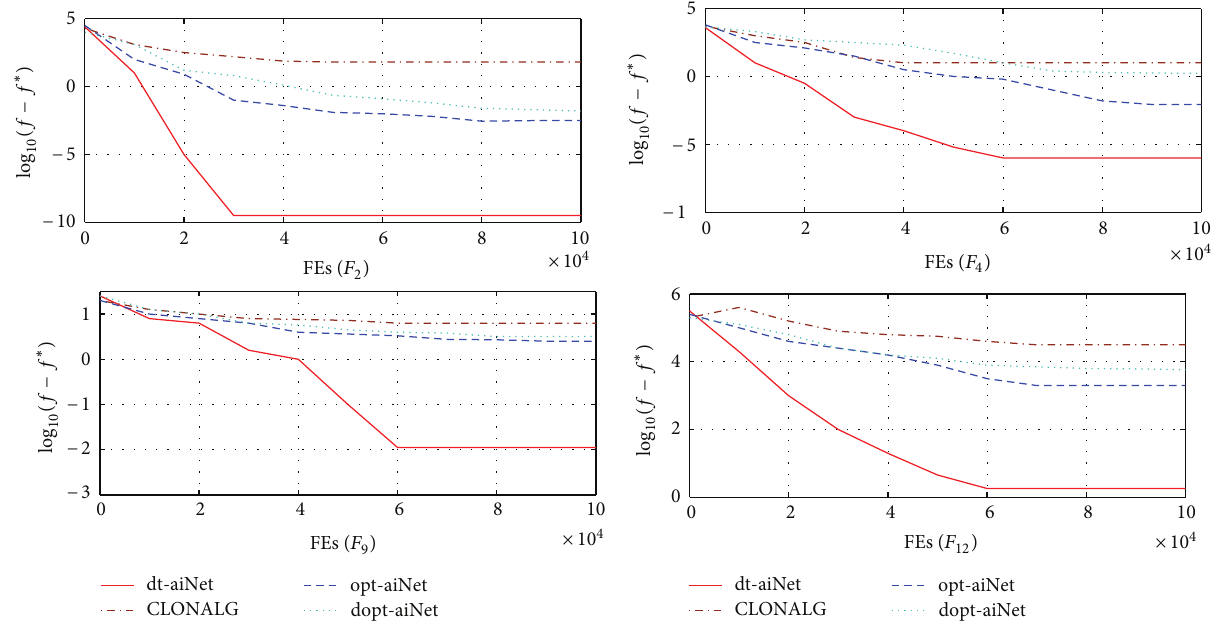
Figure 4: Convergence graphs in 10-dimensional spaces. Table 4: Results (success rates) in 2-dimensional